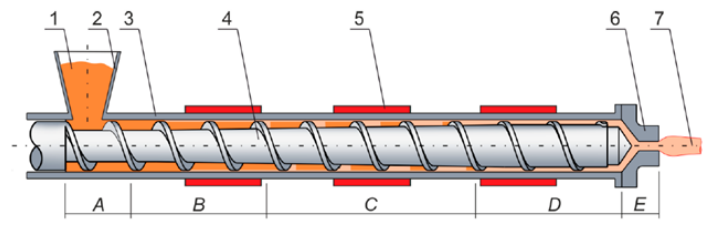
Figure 1. Scheme of the single-screw extruder: 1—solid polymer; 2—hopper; 3—barrel; 4—screw; 5—heaters; 6—die; 7—extrudate; A—solid conveying zone; B—pre-melting zone; C—melting zone; D—melt conveying zone; E—melt flow zone. Image from reference